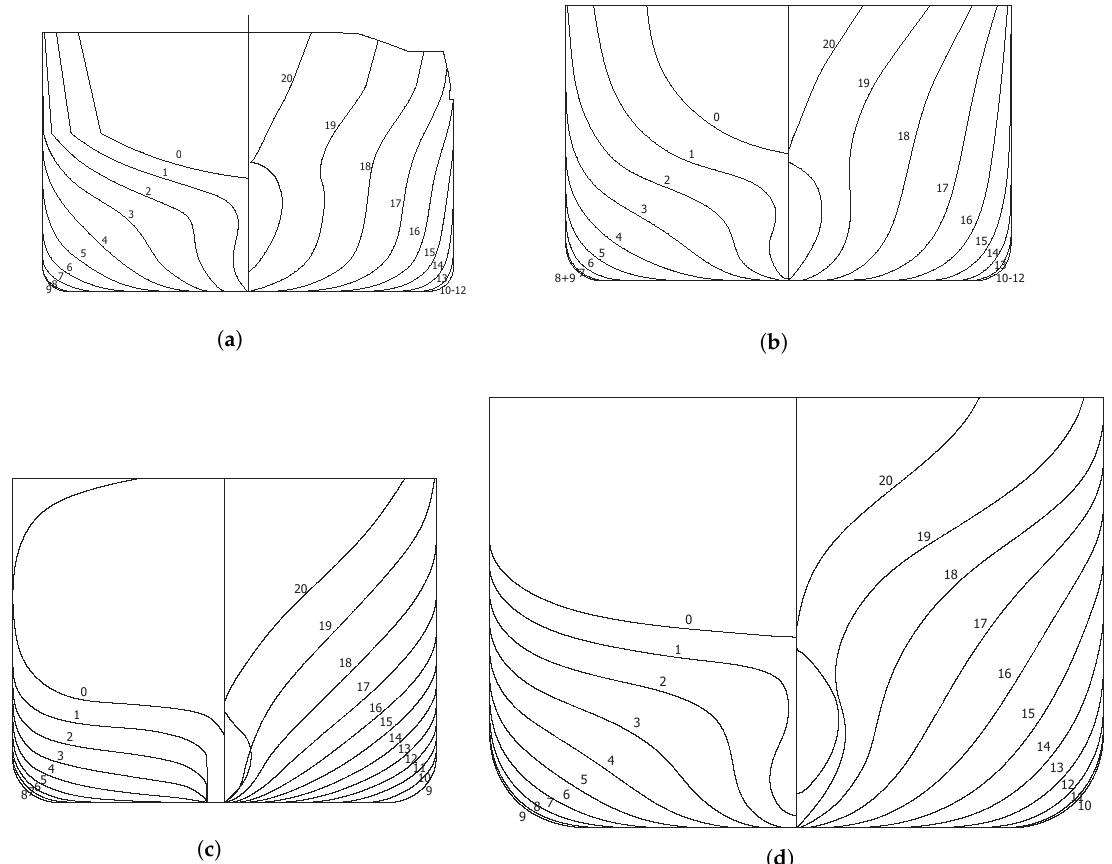
Figure 1. Body plans: ( a ) Chemical tanker, ( b ) LNG carrier, ( c ) Cruise ship, ( d )